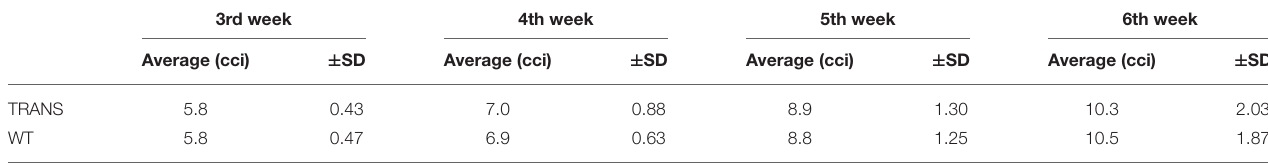
TABLE 1 | Chlorophyll content in transplastomic (TRANS) and wild type (WT) tobacco leaves from 3, 4, 5 and 6 weeks after seed sowing.